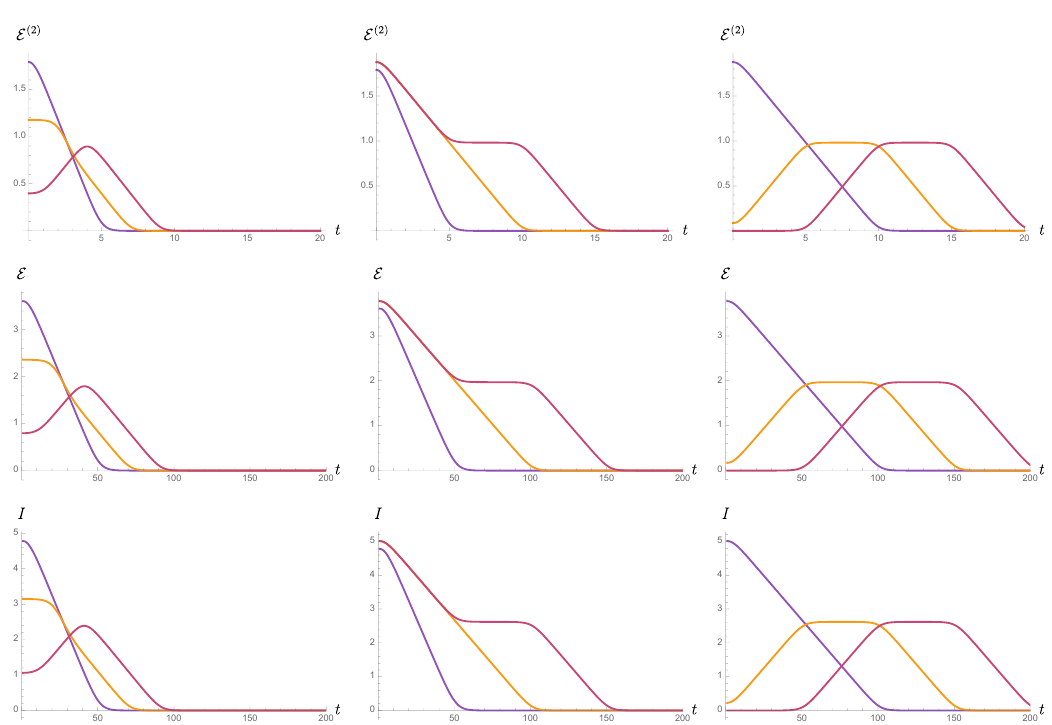
Figure 5 . Operator negativity and mutual information for free fermions. The top row is computed by (3.18). (top left) (cid:1) E (2) for free fermions with l 1 = 5, l 2 = f 5 ; 10 ; 15 g , and both intervals starting at the same position. The quantity is normalized such that the conformal factor is absent. Furthermore, it is multiplied by (cid:15) . (top middle) E (2) with l 1 = l 2 = 5, and the distance between starting positions varying as f 0 ; 2 ; 4 g . (top right) E (2) with l 1 = 5, l 2 = 10, fully overlapped (purple), adjacent (yellow), and separated by 5 (magenta). We take (cid:12) = 2. It is clear that the qualitative behavior of the negativity follows the quasi-particle picture. (middle row) Numerically computed using the same con(cid:12)gurations except all linear dimensions are scaled (cid:2) 10 and we take the replica limit using the correlator method for a system of 450 lattice sites. (bottom row) Numerically computed using the same con(cid:12)gurations except now for the BOMI using the correlator method. meaning. We have performed (cid:12)nite scaling analysis for the TOLN in the replica limit